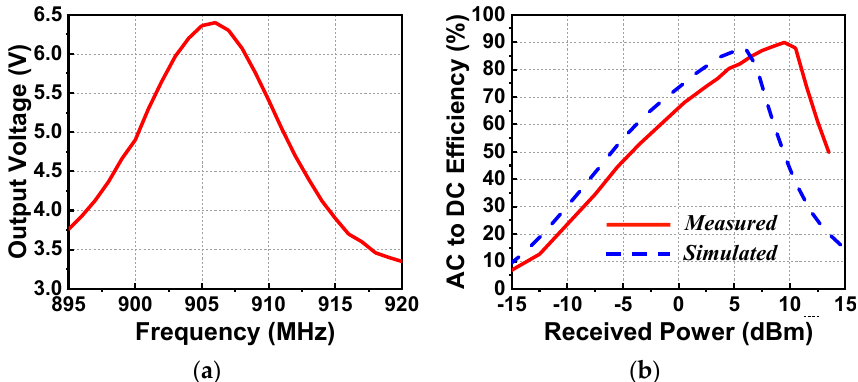
( b ) Figure 5. Sensor-augmented EAD rectenna: ( a ) experimental setup and ( b ) photocell-based prototype. In the first set of experiments, the output DC voltage as a function of the source frequency and the AC-to-DC conversion efficiency as a function of the received power were obtained. These results are shown in Figure 6. Figure 6a indicates that the peak output DC value was 6.4 V at 906 MHz when the received power was 9.5 dBm (when the output power of the signal generator was fi xed to − 13 dBm). The measured resonant frequency, 906 MHz, was only a 9-MHz shift (~1%) from its simulated value. Figure 6b compares the measured and simulation AC-to-DC conversion efficiencies as functions of the received power. The received power was calculated with the simulated gain of the EAD antenna being 1.27 dBi ( φ = 0°, θ = 180°). The peak measured efficiency was 89.9%, which was